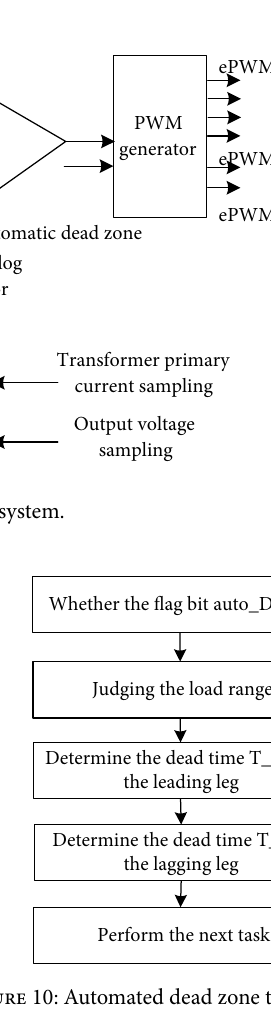
Figure 10: Automated dead zone task flow